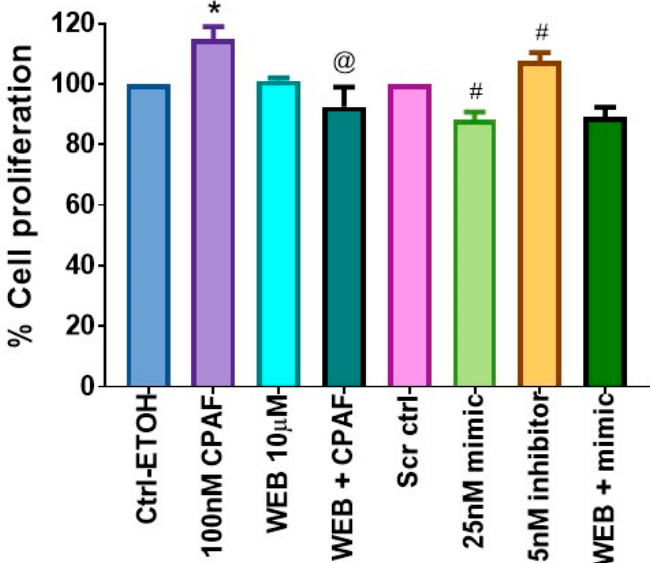
Figure 4. The effects of PAFR antagonist and miR-149-5p overexpression on A549 cell proliferation. A549 cells were pretreated with a PAFR antagonist, WEB2086 (10 µM, 1 h), followed by treatments with ± 0.1% ETOH as a vehicle and 100 nM CPAF as negative and positive controls, or transfected with a 25 nM dose of Scr ctrl (± CPAF) as a transfection control, or a 25 nM dose of miR-149-5p mimic (± CPAF) and miR-149-5p inhibitor. After 48 h of incubation, the cell proliferation was ana- lyzed via the CV assay. Data are expressed as the mean ± SE of three separate experiments. Statisti- cally significant differences were observed, according to Student’s t -test, between Ctrl-ETOH vs. CPAF (* = p < 0.05), CPAF vs. WEB + CPAF (@ = p < 0.05), Scr ctrl vs. mimic (# = p < 0.01), and Scr ctrl vs. inhibitor (# = p <